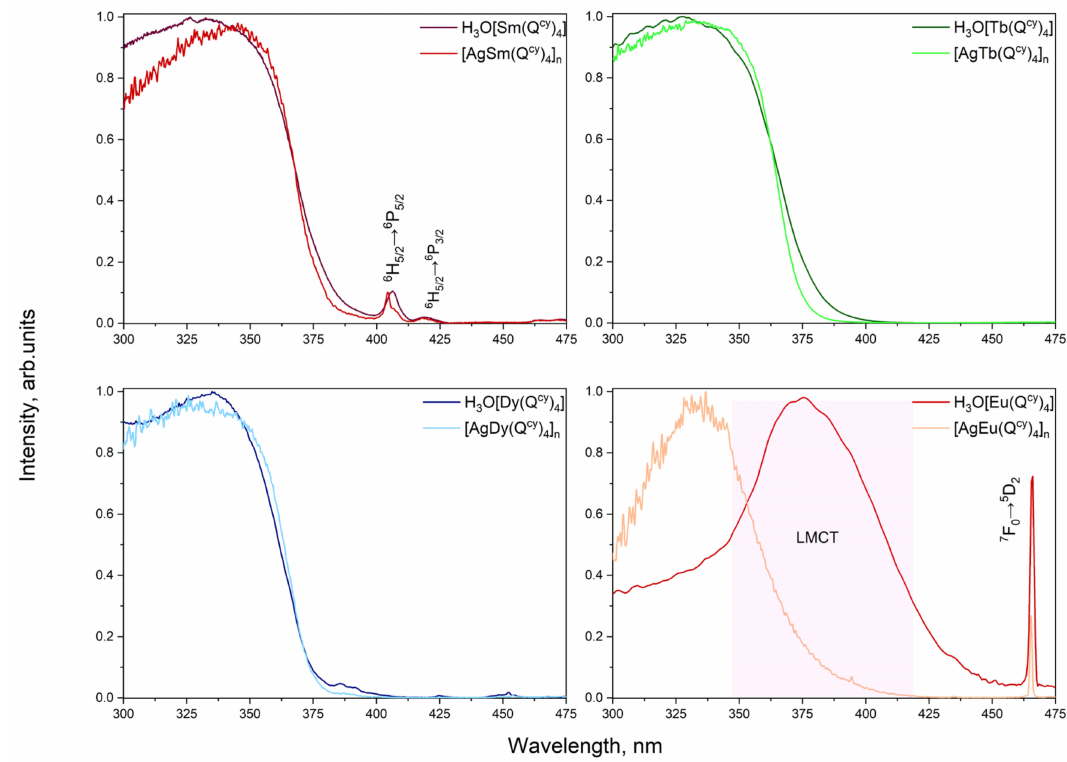
Figure 5. PL excitation spectra for all the complexes